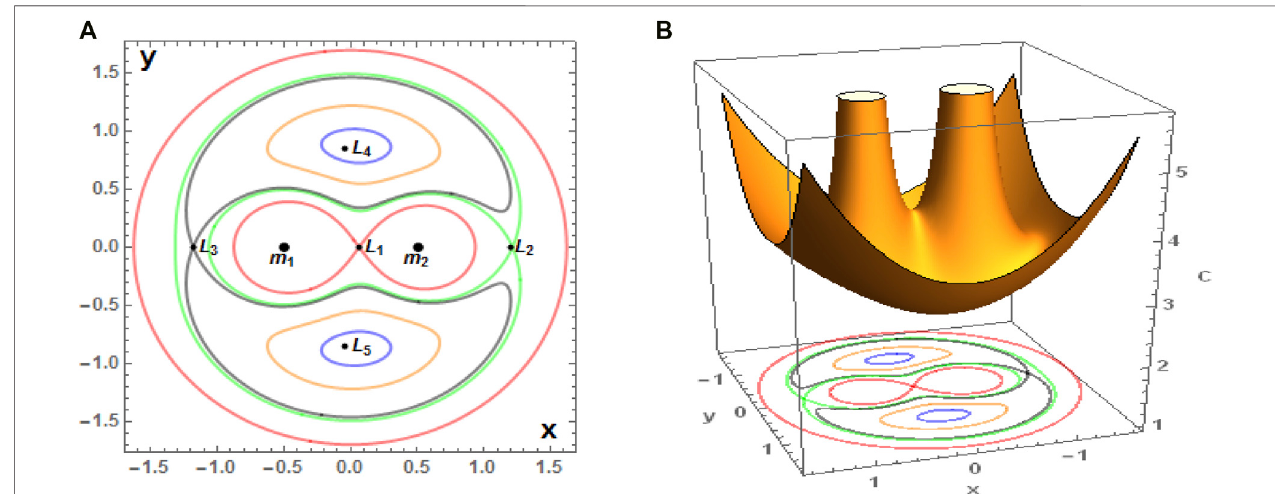
FIGURE 3 | (Color fi gure online) (A) Zero-velocity curves for μ = 0.455, σ i (cid:1) σ ′ i (cid:1) 0, i = 1, 2, M b = A 3 = 0, q 1 = q 2 = 1, and Jacobi constant values: C (cid:1) C L C (cid:1) C L ( greenline ), C = C L 3 ( blackline ), C =3( yellowline ),and C =2.8( blueline ).Thetwoprimarybodiesaredenotedby m i i =1,2,whilethe fi veequilibriumpoints L i , i = 2 1,...,5, are indicated by small circles. (B) Surface and the corresponding zero-velocity curves of the problem in the gravitational case.